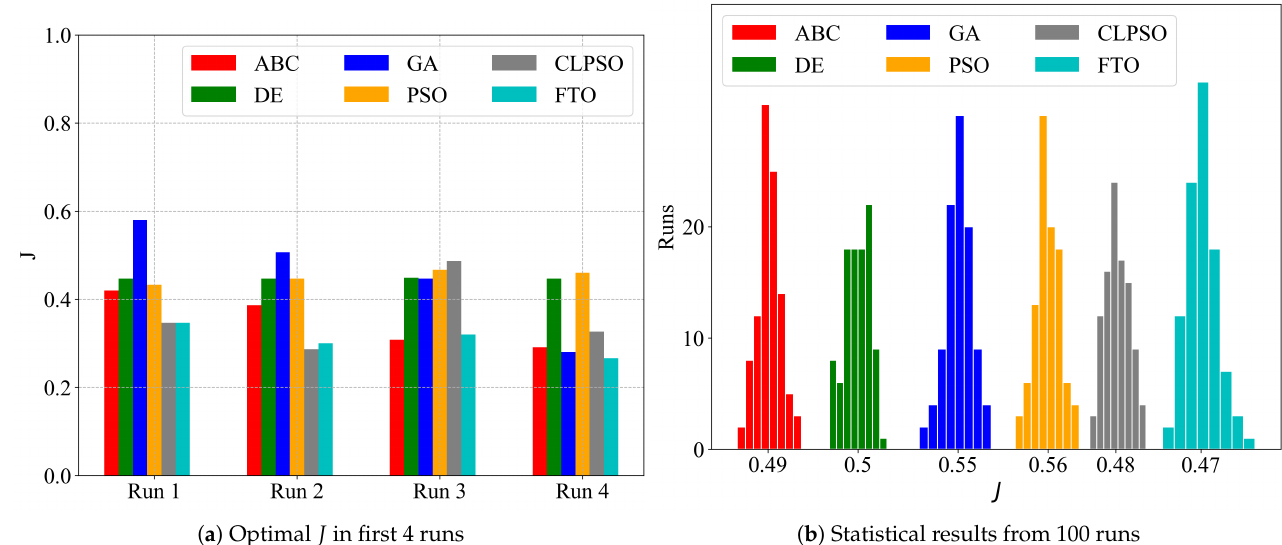
Figure 16. Test results of FTOS scheduling with parameters optimized by different algorithms.